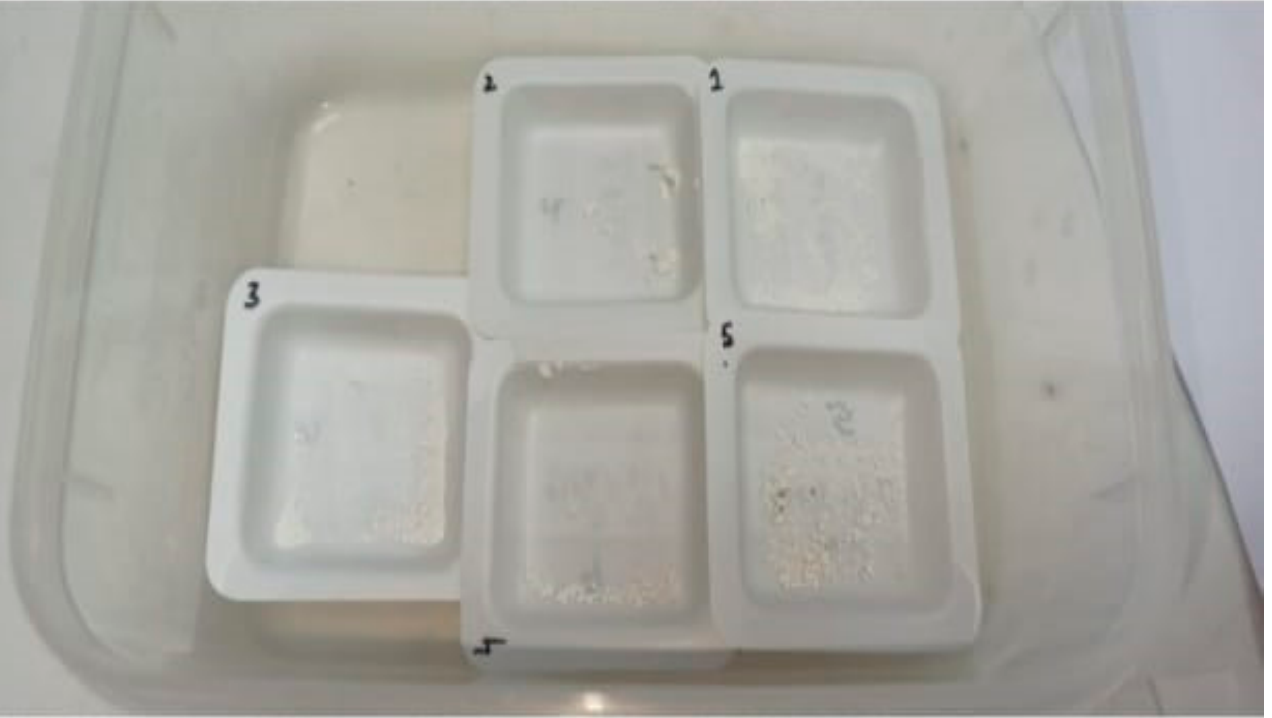
Figure 1. Crushed samples of the five root canal sealers.